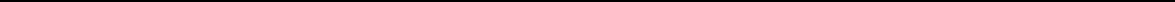
Fig. 2 H1152 promotes the maturation of hESC-derived glucose-responding cells. a Scheme of the directed differentiation protocol. b Flow cytometry analysis, the percentage of INS-GFP + cells and the mean signal of INS-GFP + cells of DMSO and H1152 treated spheres. c – e Confocal imaging ( c ) intracellular FCM ( d ) and qRT-PCR ( e ) analysis of H1152-treated or DMSO-treated spheres. N = 3 – 6 independent biological replicates. Scale bar = 25 μ m. Error bar is SEM. Primary human islets were used as a control in Fig. 2e. UCN3: urocortin3, SS: somatostatin, PP: pancreatic polypeptide. f Total c-peptide content of H1152-treated or DMSO-treated spheres, compared with human islets. g KCl-stimulated insulin secretion of H1152-treated or DMSO-treated spheres. h GSIS of H1152-treated or DMSO-treated spheres. N = 8 – 12 independent biological replicates. n.s. indicates non-signi fi cant difference. p -values were calculated by unpaired two-tailed Student ’ s t -test. * p < 0.05, ** p < 0.01. AA Activin A; Ch Chir; Glc Glucose; RA Retinoic acid; KSIS KCl stimulated insulin secretion; GSIS Glucose stimulated insulin secretion. The bottom and top of the box represent the fi rst and third quartiles, the band inside the box represents the median. The ends of the whiskers represent the minimum and maximum of all the